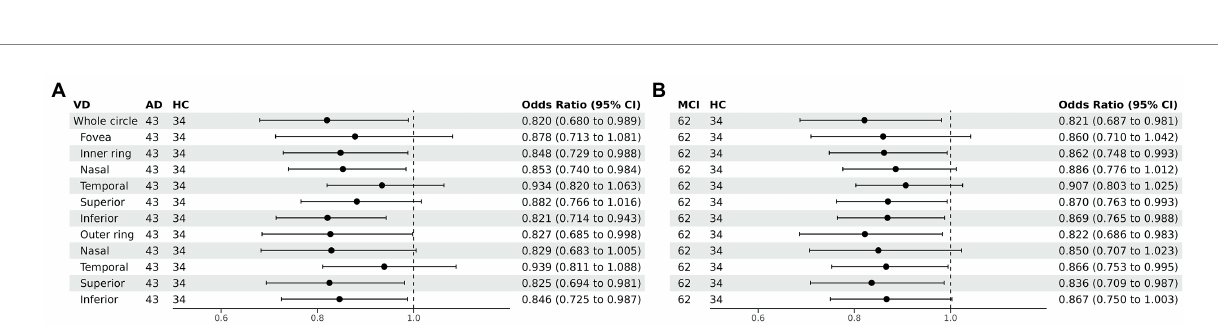
FIGURE 4 Forest plot of vessel density comparison among three groups. Multiple logistic regression was used to access the association between retinal vessel density and clinical diagnosis, adjusted for confounders of sex, age, history of smoking, history of alcohol intake, hypertension, hyperlipidemia, BCVA, and IOP. (A) Compared with HC group, vessel density decreased significantly in the nasal and inferior regions of the inner ring and in the superior and inferior regions of the outer ring in the AD group. (B) Compared with HC group, vessel density decreased significantly in the superior and inferior regions of the inner ring and in the temporal and superior regions of the outer ring in the MCI group. VD, vessel density; AD, Alzheimer’s disease; MCI, mental cognitive impairment; HC, healthy controls; CI, confidence interval.